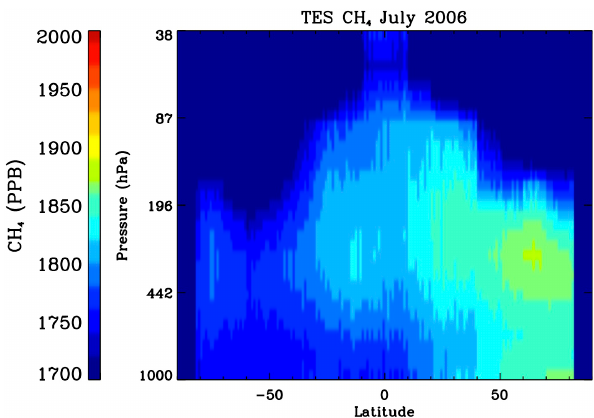
Fig. 12. TES CH 4 as a function of latitude after applying N 2 O Figure 12: TES CH 4 as a function of latitude after applying N 2 O correction.